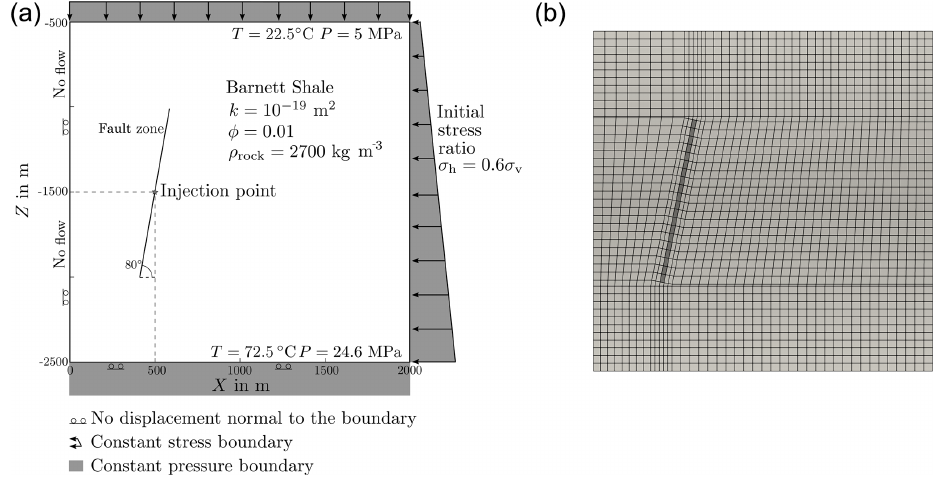
Figure 1. Set-up of the hydraulic fracturing scenario after Rutqvist et al. (2013) (a) and domain discretisation (b) .